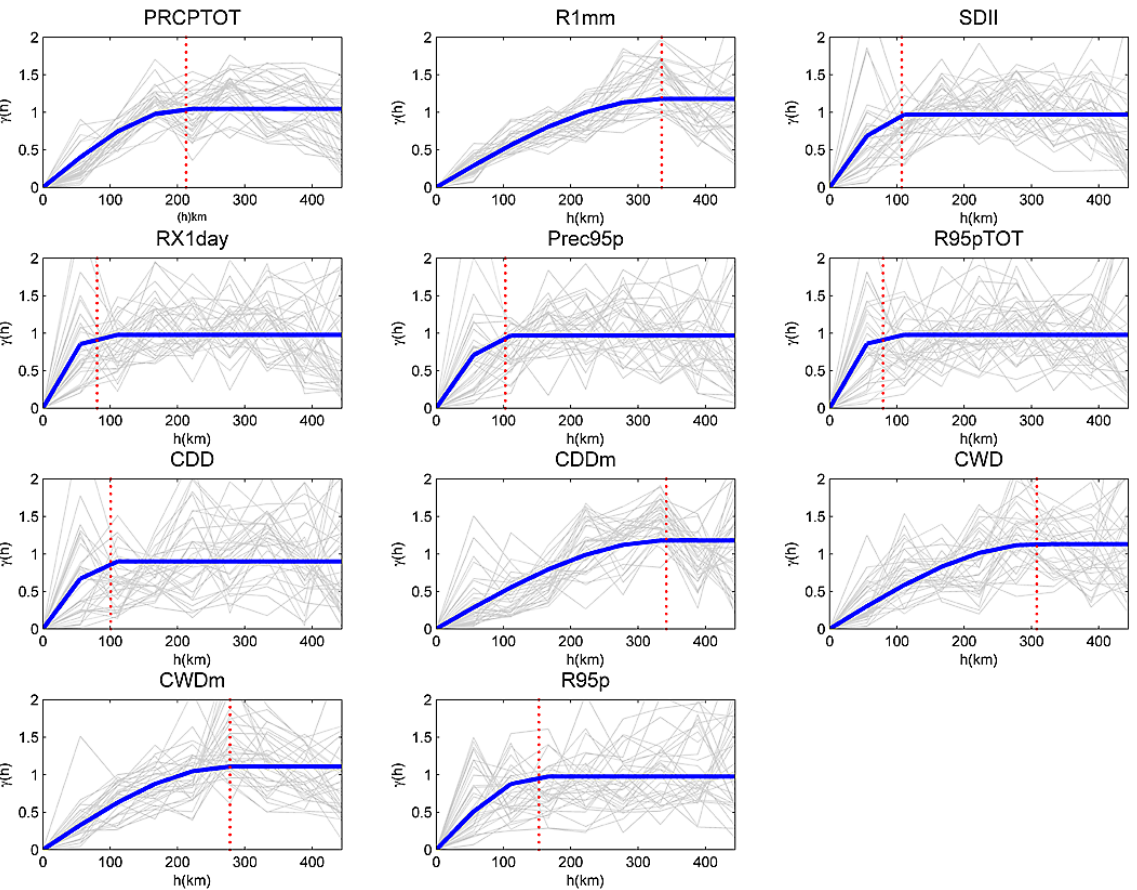
Fig. 5. Scaled empirical variograms ( γ ) computed for the indices each year (grey lines). The thick blue lines represent the fitted spherical variogram models, the red dotted lines are the values of the range parameters for the variogram